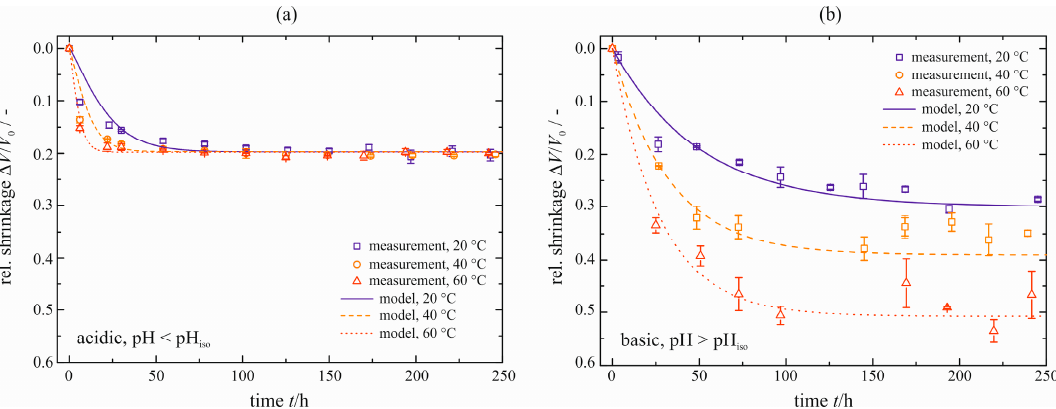
Figure 8. Relative shrinkage Δ V / V 0 of the cylindrical samples, natural syneresis for different temperatures ϑ , acid-catalyzed [5] ( a ), and base-catalyzed ( b ). Table 1. Maximum shrinkage Δ V / V 0 | max and characteristic time constant τ for the cylindrical samples ( d Cyl = 12 mm and V Gel ≈ 3 mL), natural syneresis, model parameters.